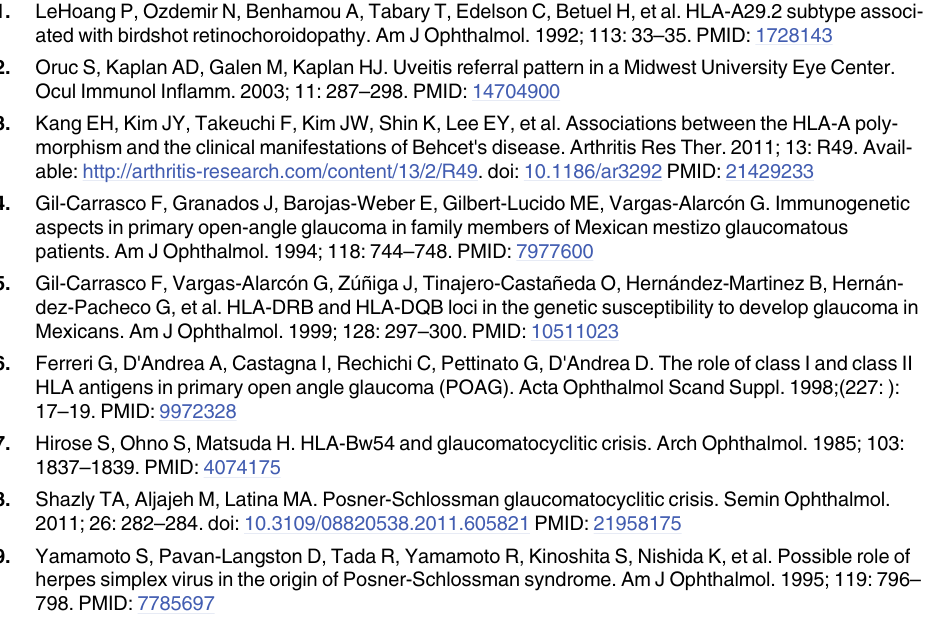
PLOS ONE | DOI:10.1371/journal.pone.0132179 July 10,